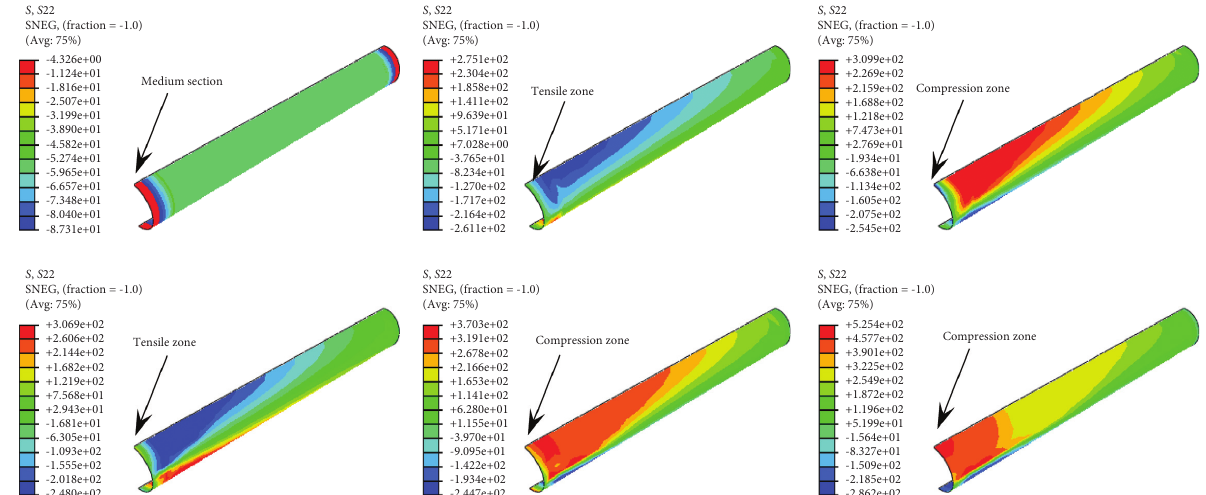
Figure 20: The longitudinal stress distribution of the steel tube in specimens.